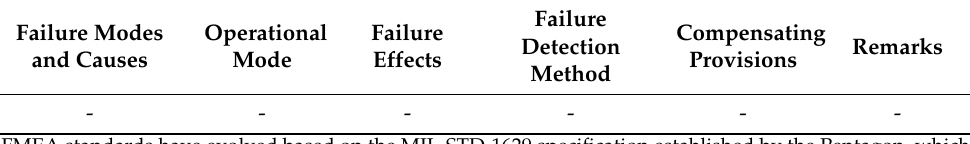
Table 2. FMEA format of MIL-STD-1629